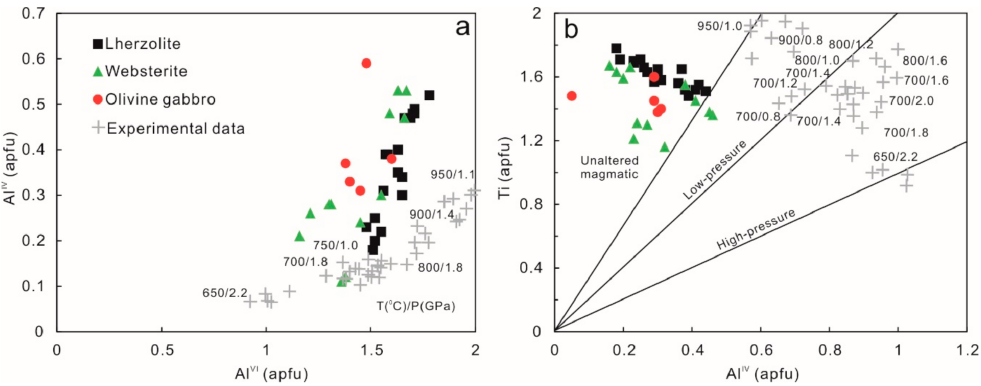
Figure 7. Diagrams of Al VI -Al IV ( a ) and Al IV -Ti ( b ) of amphibole in the Baixintan deposit: grey cross symbols are the experimental result of T–P conditions for various compositions of synthesized amphibole [64].